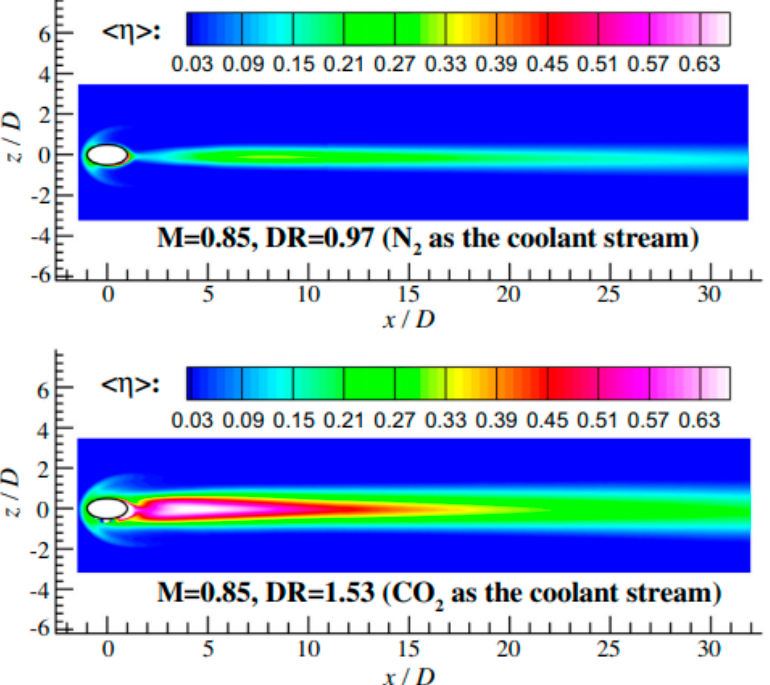
Figure 14. Film cooling effectiveness with PSP technique [72].